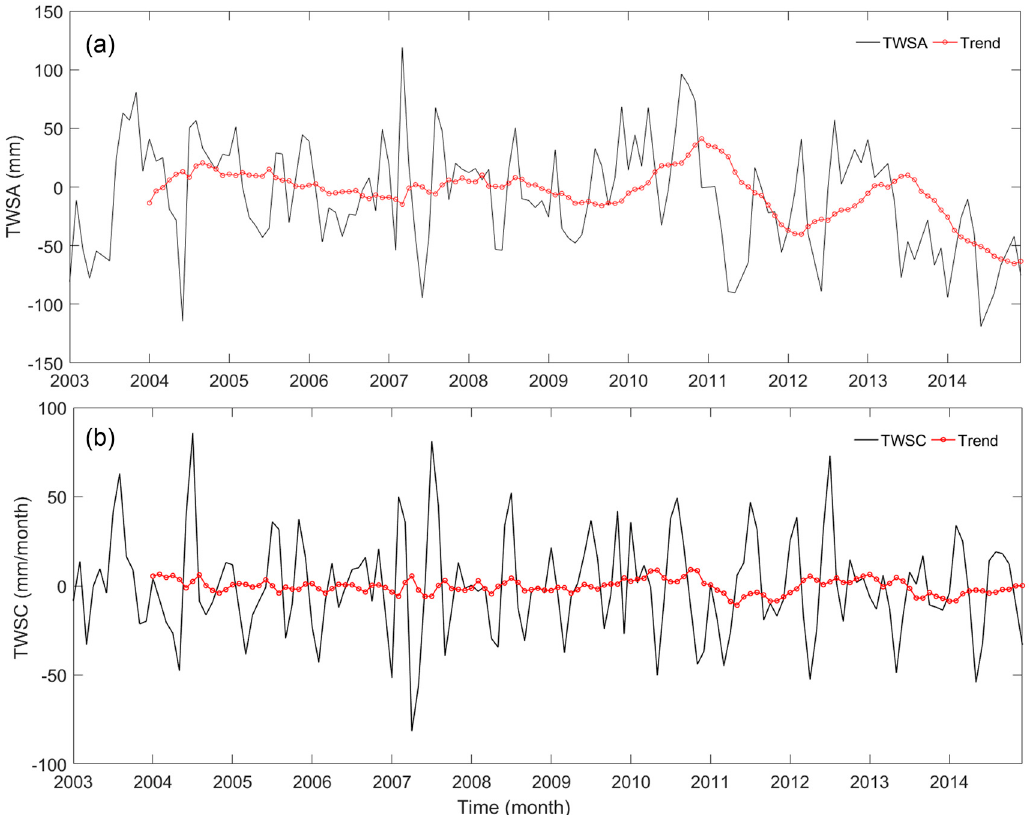
Figure 2. The time series of ( a ) Gravity Recovery and Climate Experiment (GRACE)-based terrestrial water storage anomaly (TWSA) and ( b ) terrestrial water storage changes (TWSC) with trends during the study period.